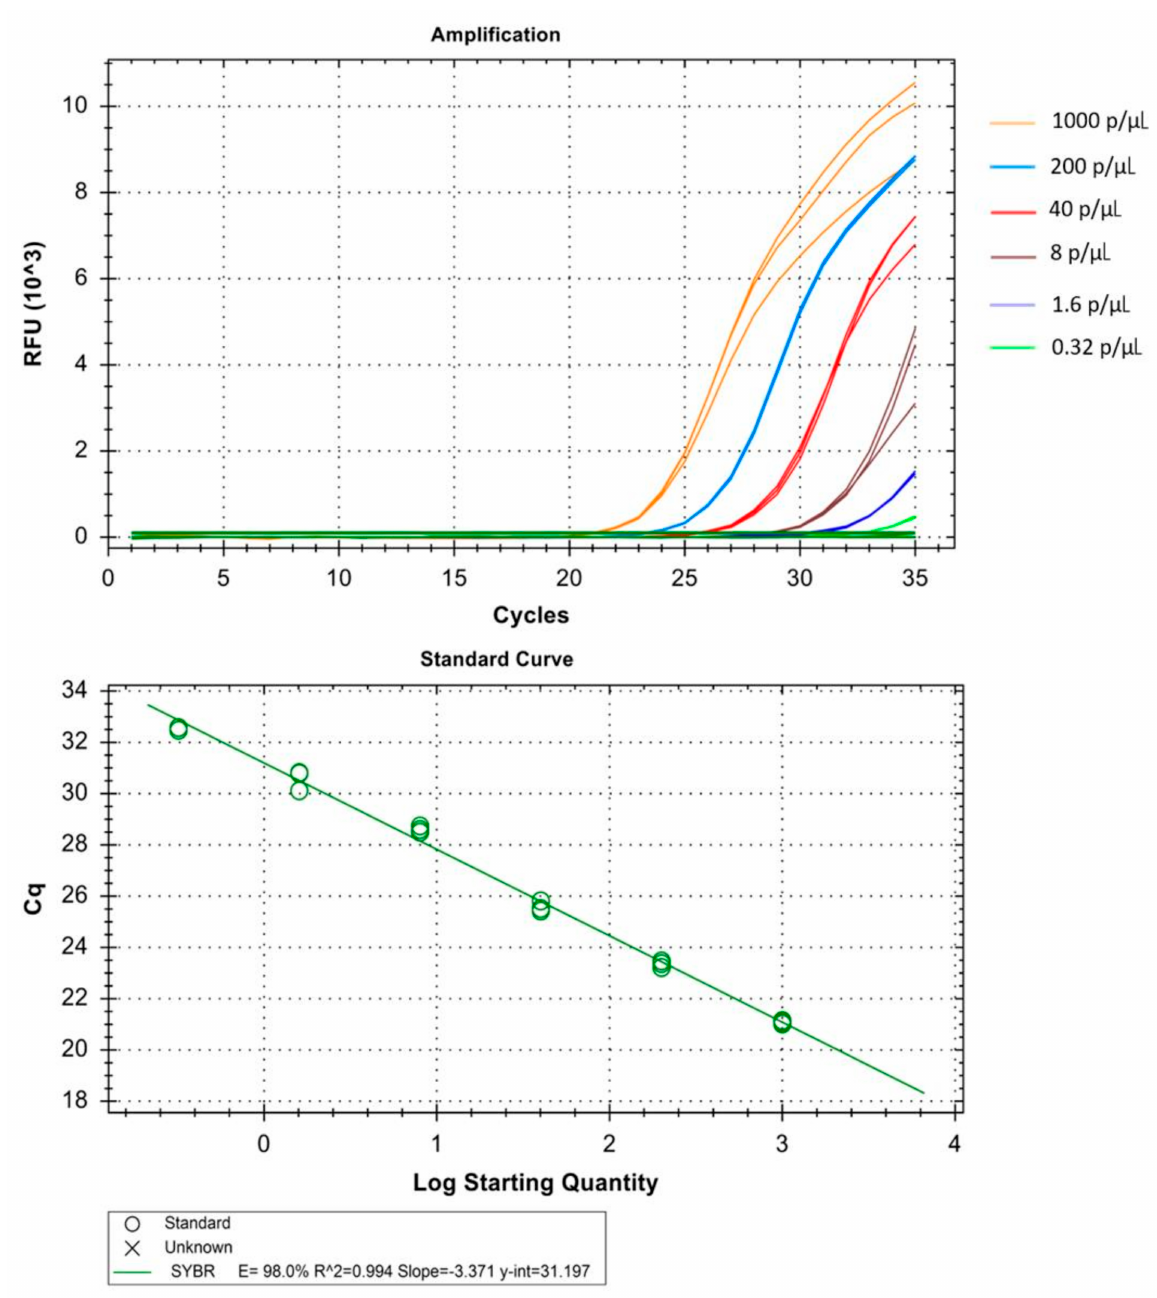
Figure 7. Technical performance and range of detection of the Pm , real-time SYBR green PCR. Amplification curves of archived Pm samples with concentration ranging from 1 × 10 3 to 3.2 × 10 − 1 parasites/ µ L, have been depicted by different colors each containing a different parasite load. The standard curve has been made by the ct values obtained from the assay plotted against the logarithmic parasite concentration in a linear regression curve fit analysis (R 2 = 0.994, E =